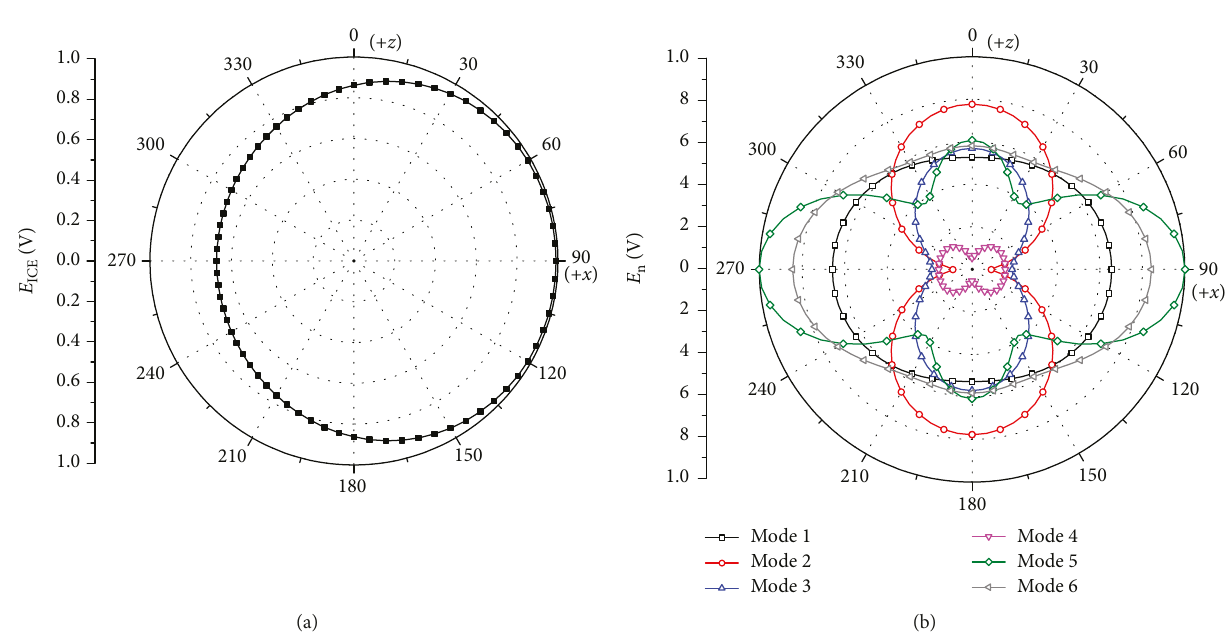
Figure 7: Radiation patterns of the total fi eld and the fi rst six modes for the ICE-fed antenna on the xoz plane of φ = 0 ° at 2.2 GHz: (a) total fi eld using the full-wave method and (b) far fi eld for the fi rst six modes.